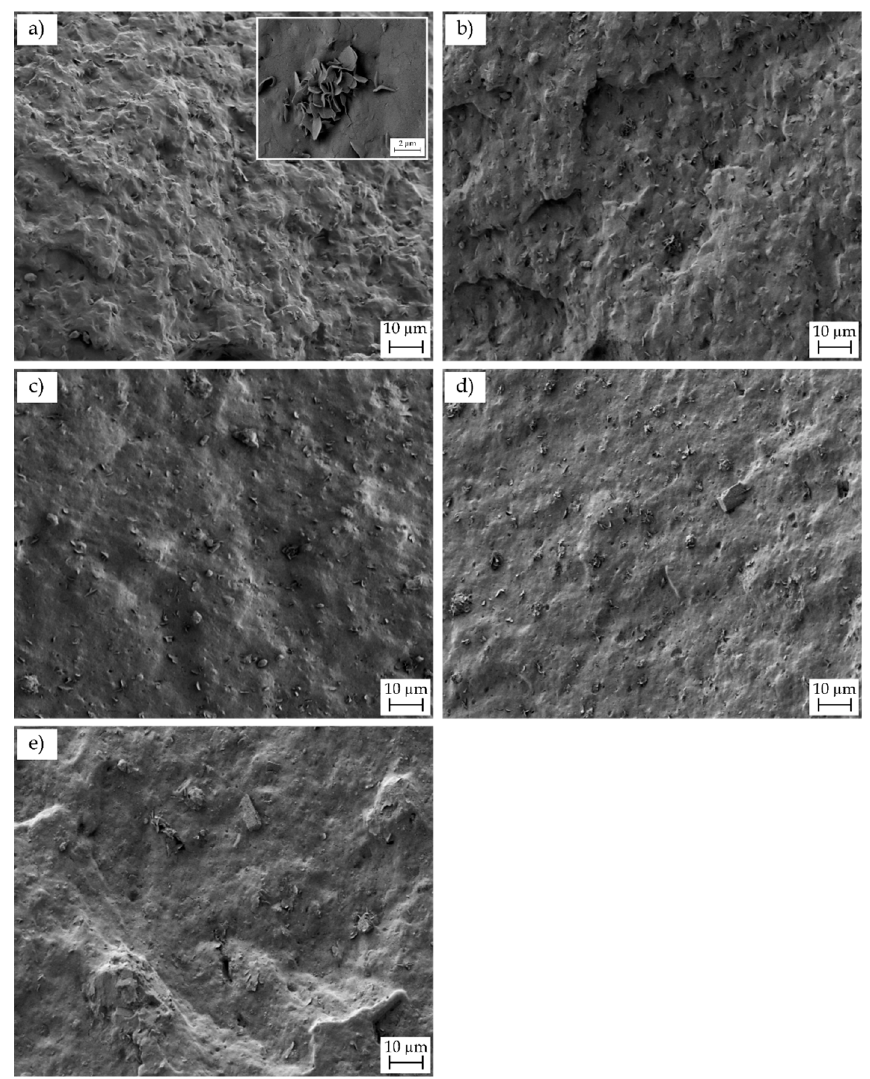
Figure 8. Field-emission scanning electron microscopy (FESEM) images of the fracture surfaces of the injection-molded poly(3-hydroxybutyrate- co -3-hydroxyhexanoate) [P(3HB- co -3HHx)]/hydroxyapatite nanoparticle (nHA) parts of: ( a ) neat P(3HB- co -3HHx); ( b ) P(3HB- co -3HHx) + 2.5 nHA; ( c ) P(3HB- co -3HHx) + 5 nHA; ( d ) P(3HB- co -3HHx) + 10 nHA; ( e ) P(3HB- co -3HHx) + 20 nHA. Images were taken at 500 × and with scale markers of 10 µ m. Inset image showing the detail of the microparticles was taken at 2500 × with scale marker of 2 µ